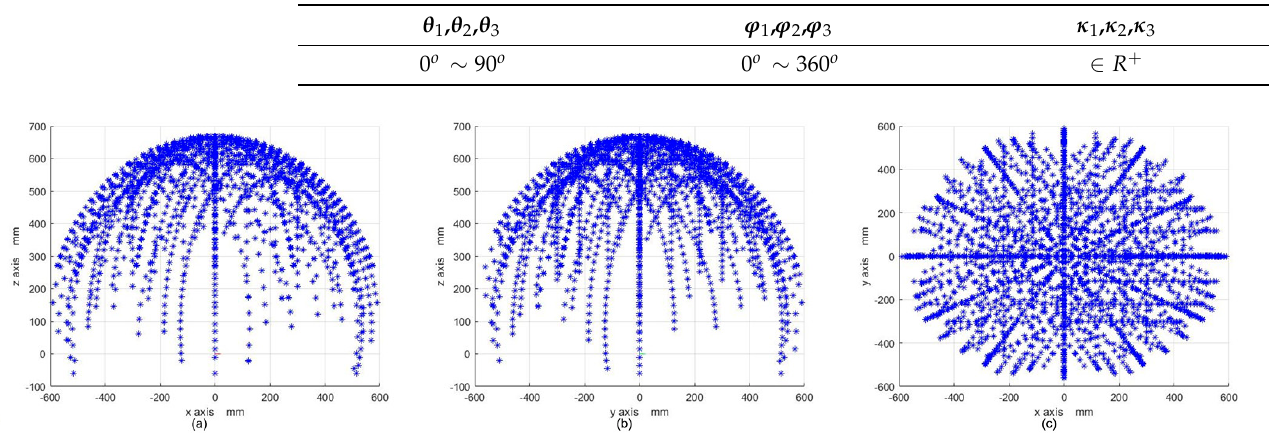
Table 2. Limitations of the arc parameters.